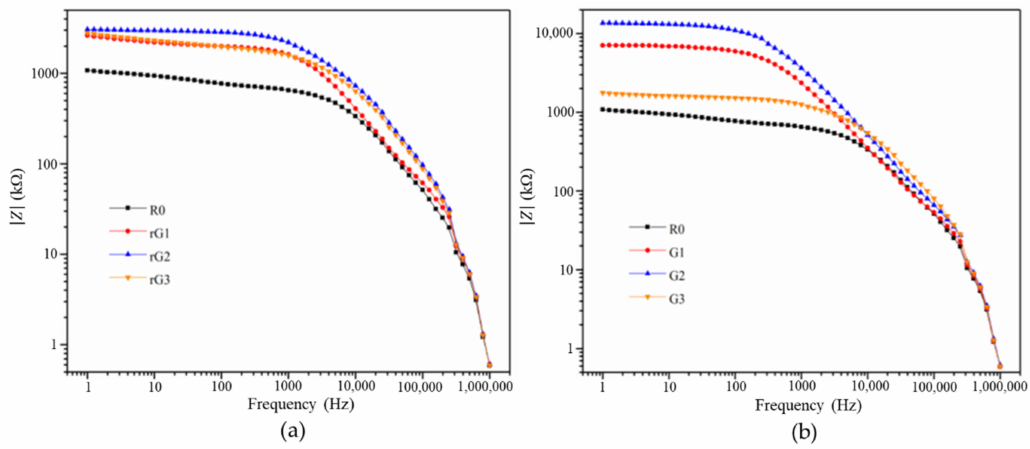
Figure 14. Bode curves of the samples with rGO ( a ) and GO ( b ) addition.